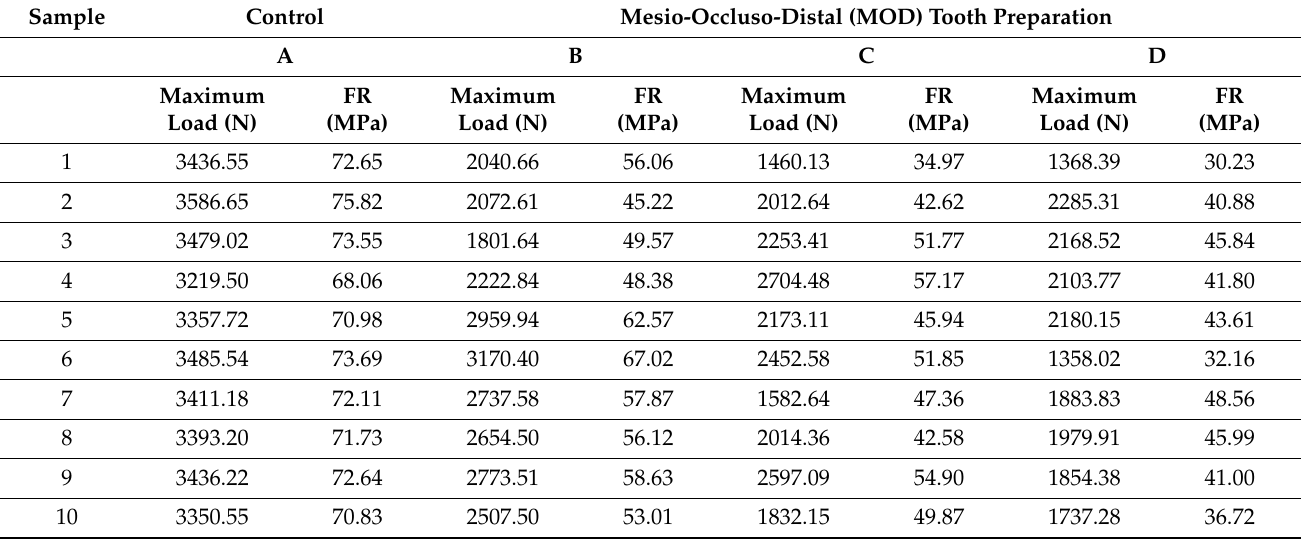
Table 1. Maximum load and fracture-resistance scores of samples in different groups.